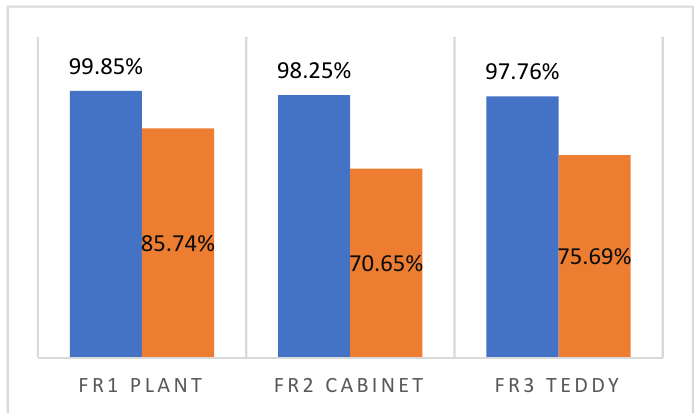
Figure 8. Performance comparison between the model-specific and global CNN object detectors using example datasets: from left to right are the results of ‘freiburg1_plant’, ‘freiburg2_caninet’, and ‘freiburg3_teddy’. The left column and the right column in each cell are the results of the model-specific and the global CNN object detectors, respectively. Table 1. The confusion matrix of integrating multiple model-specific CNN object detectors for detecting all objects under surveillance.